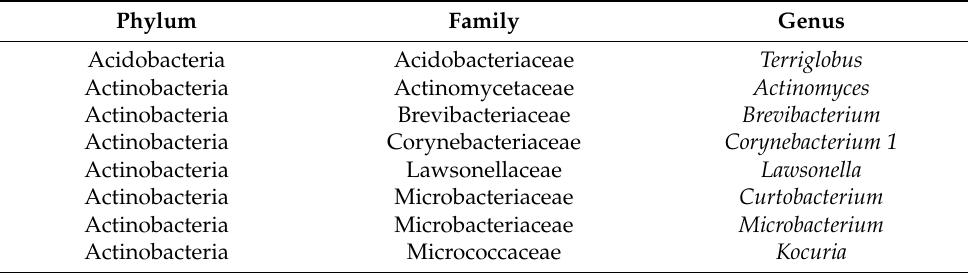
Table 1. Phyla, families and genera of bacteria detected in the metagenomic study of the Agrilus planipennis larval gut microbiome in European